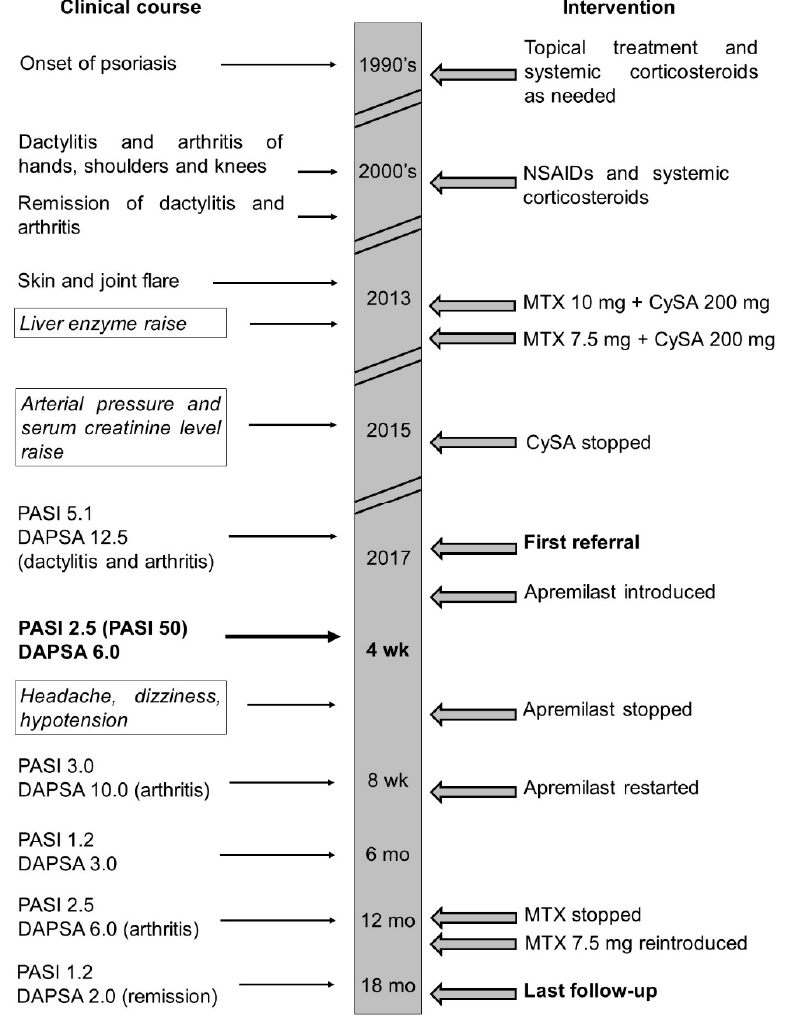
Figure 1. Case report timeline. Clinical course (left) and interventions (right) are described.